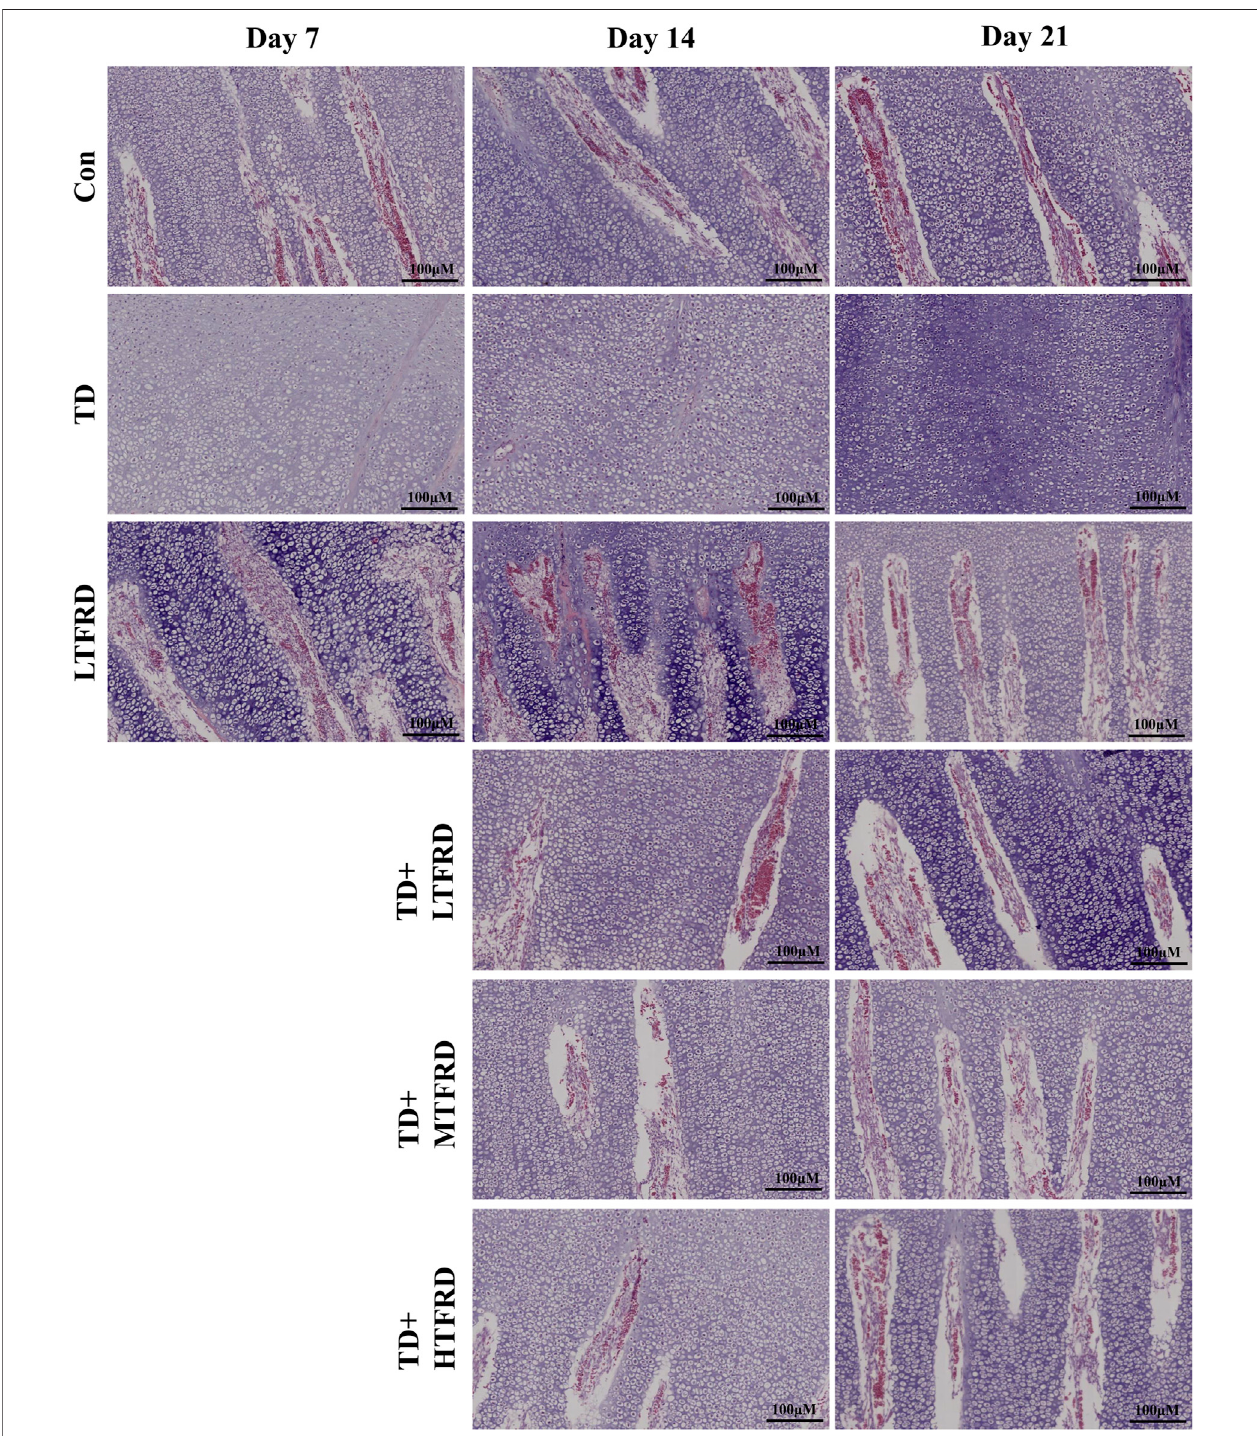
FIGURE 3 | Effects of TFRD on vascular invasion of tibial growth plate in TD broilers. HE staining was used to observe the vascular in fi ltration of growth plates in each group. The black arrow points to the blood vessel. Scar bar = 100 µm.